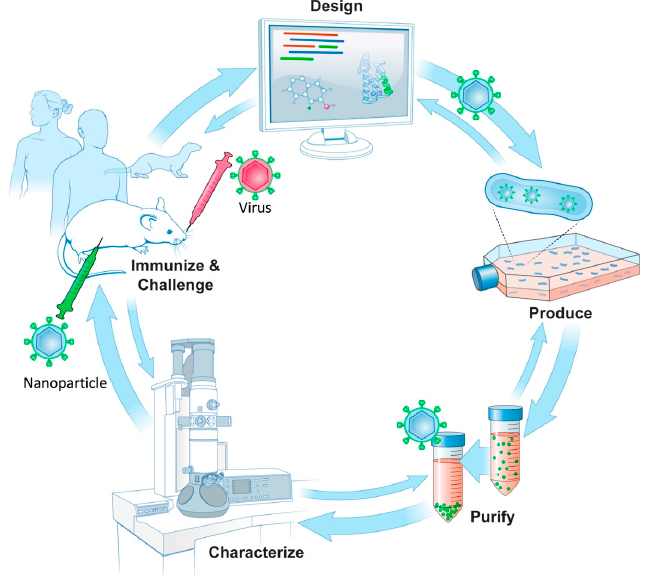
Figure 6. Schematic of structure-guided immunogen design integrated into a vaccine development pipeline. (Design) A conserved epitope from a surface antigen (green) is designed into a fusion protein in order for epitope display on a nanoparticle. Design uses bioinformatics taking into account conserved sequences and epitopes along with structural and molecular modeling of nanoparticle structures in silico. (Produce) To produce nanoparticles, protein encoding DNAs are synthesized and screened for protein expression and nanoparticle formation. (Purify) Nanoparticle production and purification is scaled for further characterization. (Characterize) Immunoassays and biophysical techniques such as electron microscopy are used. 3D structures can be produced by cryo-EM to assess particle integrity, along with epitope display and conformation. (Immunize, Challenge) Immunogenicity and challenge studies using nanoparticles as immunogens can be carried out in animal models, such as mice and ferrets with progression into human studies. Double arrows denote the general iterative nature among steps in the process of structure-guided antigen design within a vaccine pipeline.